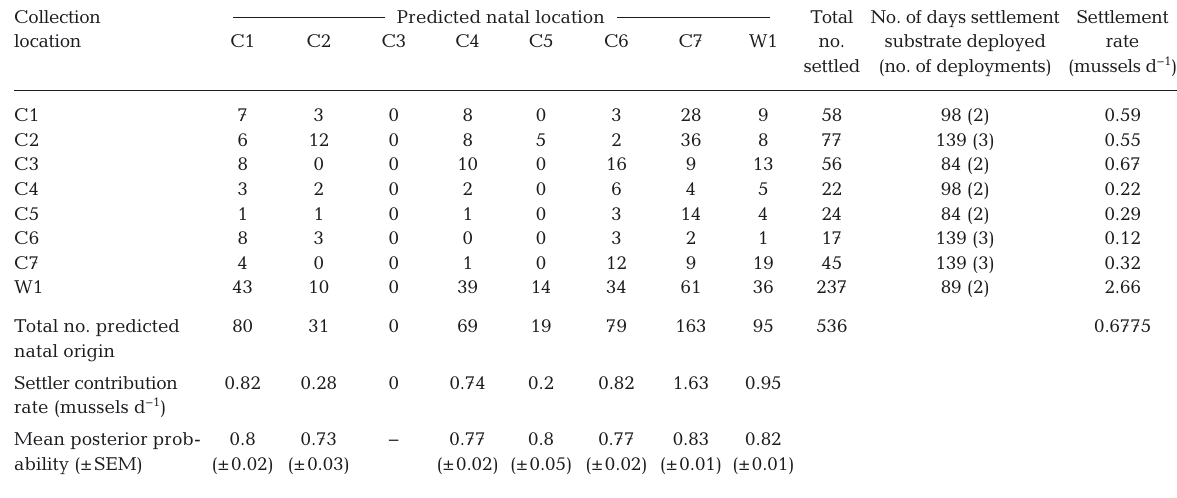
Table 3. Predicted formation locations of Perna canaliculus shell material at the prodissoconch of individuals which settled at monitored sites in the Firth of Thames between January and May 2018. As weather events resulted in non-standard